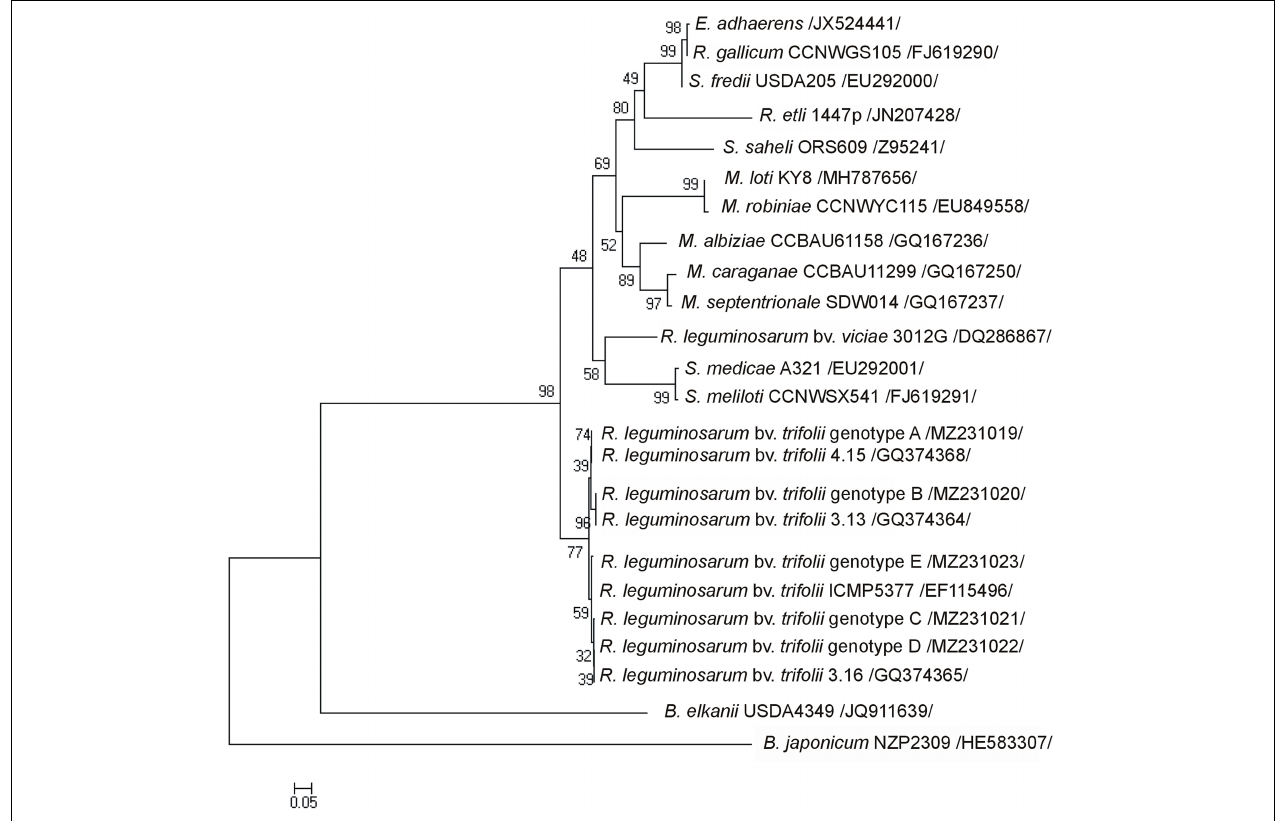
FIGURE 1 | The phylogenetic Neighbor Joining tree based on 416-bp nodA gene sequences showing the relationship of R. leguminosarum bv. trifolii genotypes (A–E) and reference strains (the GenBank database). Numbers at nods indicate levels of bootstrap support based on an analysis of 1,000 resampled data sets. Accession numbers of reference strains representative of the studied strains are shown in parentheses. The scale bar indicates the number of substitutions per site.